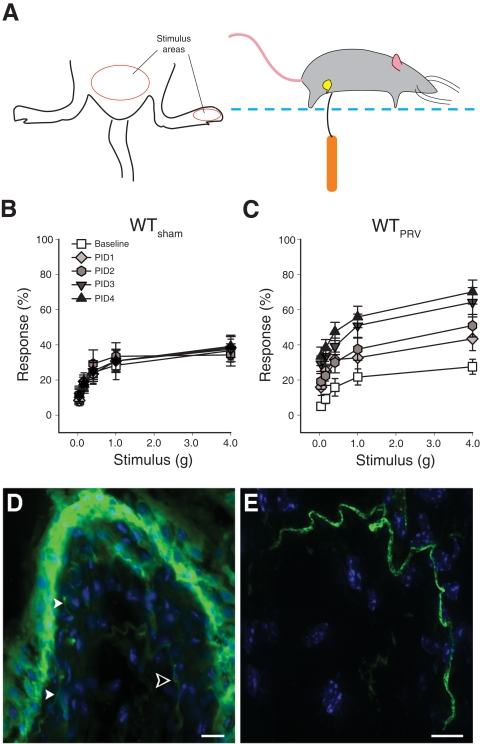
PRV induces pelvic pain.A) Tactile sensitivity was assessed by stimulating the suprapubic and hindpaw skin with von Frey filaments (left panel) of a mouse placed into a chamber with a mesh floor (right panel). Referred visceral hyperalgesia was measured in female mice as responses to mechanical stimulation of the pelvic region using von Frey filaments of 5 calibrated forces. Data represent the mean response to ten successive applications for each fiber ±SEM at baseline and at PID 1, 2, 3, and 4 following infection with 2.3×106 pfu Bartha's PRV in the tailbase muscle. B) Responses to pelvic stimulation of C57BL/6J mice sham-infected with inactivated PRV (n = 12). The symbol key shown in (B) also applies to panel (C). C) Responses to pelvic stimulation of C57BL/6J mice infected with PRV reveal enhanced sensitivity to suprapubic stimuli (n = 12). ANOVA indicated a significant increase in responses from baseline at all filaments tested in PRV-treated mice at PID 2, 3 and 4 (P<0.05). D) Fluorescein-isolectin B4 staining (green) of bladder tissue reveals processes in the lamina (arrowheads). E) A single isolectin-stained fiber (open arrowhead in D) is shown at higher magnification. The mean diameter is 1.31 µm along its length of 1071 µm. Scale bars represent 16 µm and 10 µm for D and E, respectively.